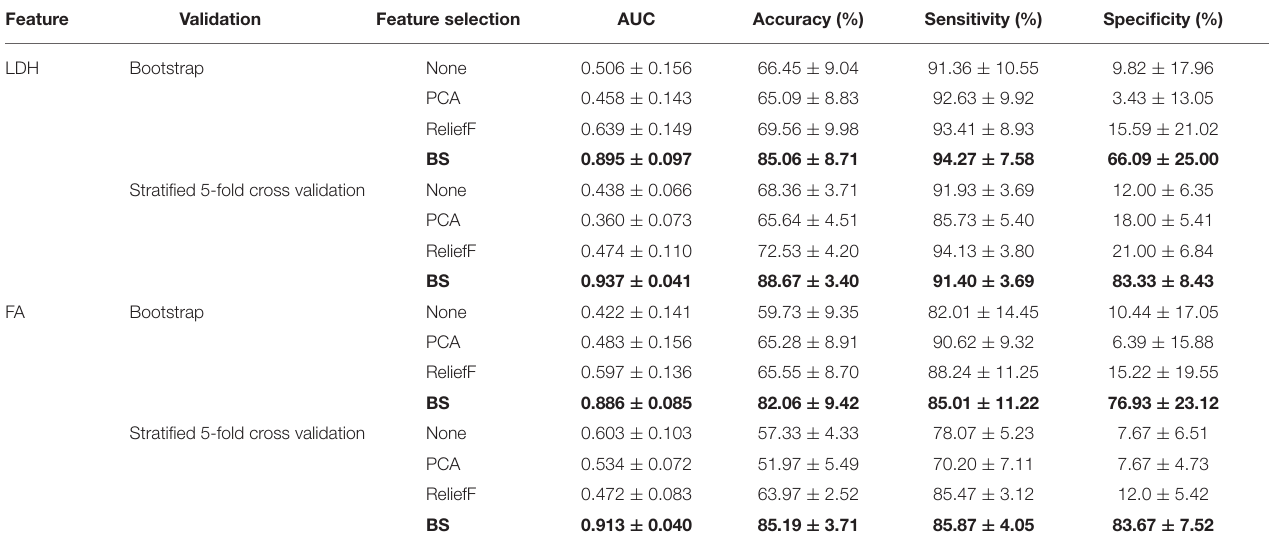
Values expressed as mean ± deviation. Bold indicates the best performance in different settings. None indicates no feature selection. AUC, area under curve; BS, beam search; FA, fractional anisotropy; LDH, local diffusion homogeneity; PCA, principal component